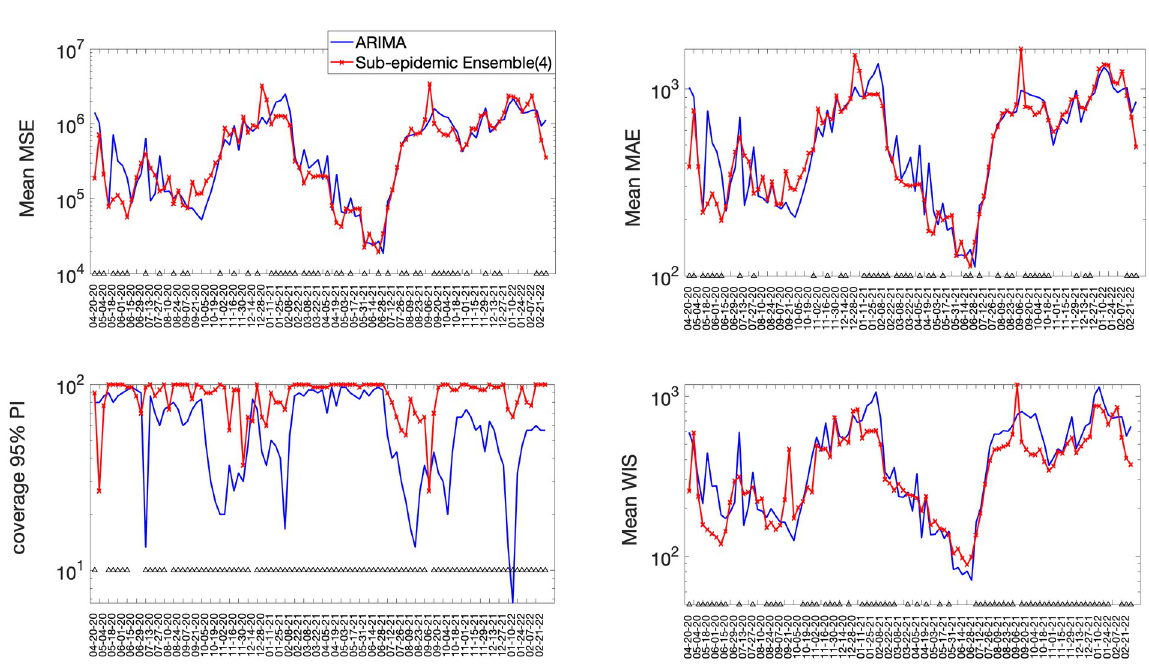
Fig 5. Forecasting performance metrics for the ARIMA and Ensemble(4) models across 98 30-day forecasts. The symbol (^) indicates weekly forecasts where the Ensemble(4) model outperforms the ARIMA model. For instance, the Ensemble(4) outperformed the ARIMA model 69.4% of the time in terms of the WIS and 91.8.8% of the time in terms of the coverage rate of the 95% PI (Figs 3 and 5).